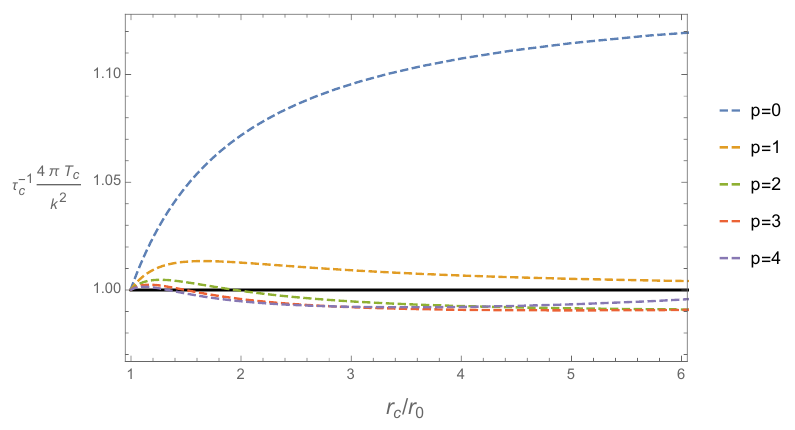
, which is multiplied by 4 (cid:25)T c , in terms of the position c k 2 4 (cid:25)T c c k 2